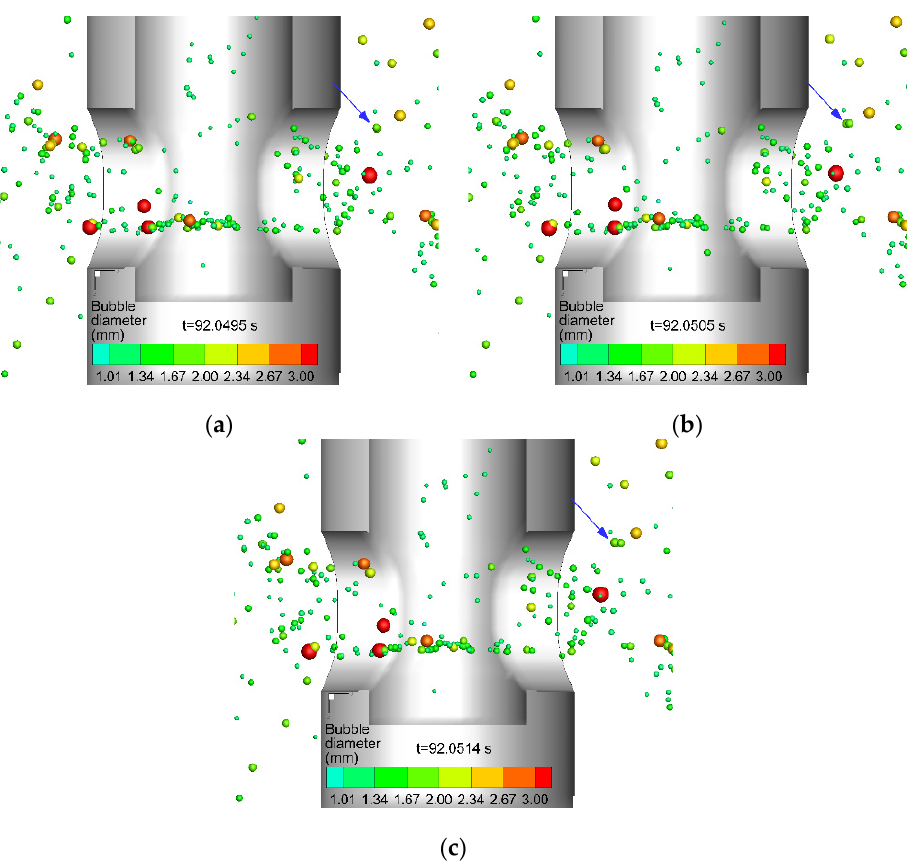
Figure 6. The typical process of the coalescence of bubbles (marked by a blue arrow), ( a ) t = 92.0627 s, ( b ) t = 92.0651 s, and ( c ) t = 92.0657 s.